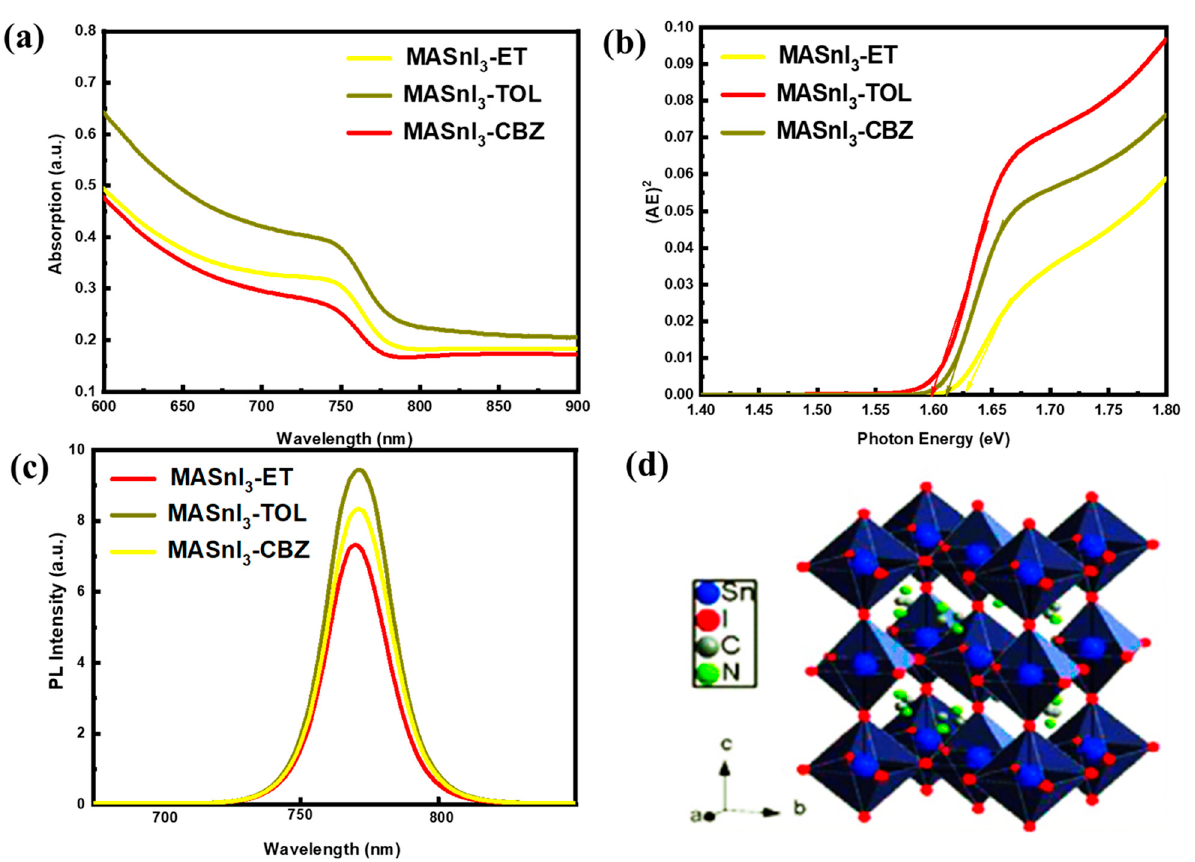
Figure 2. SEM images of MASnI 3 films treated with ( a ) diethyl ether, ( b ) toluene, ( c ) chlorobenzene.